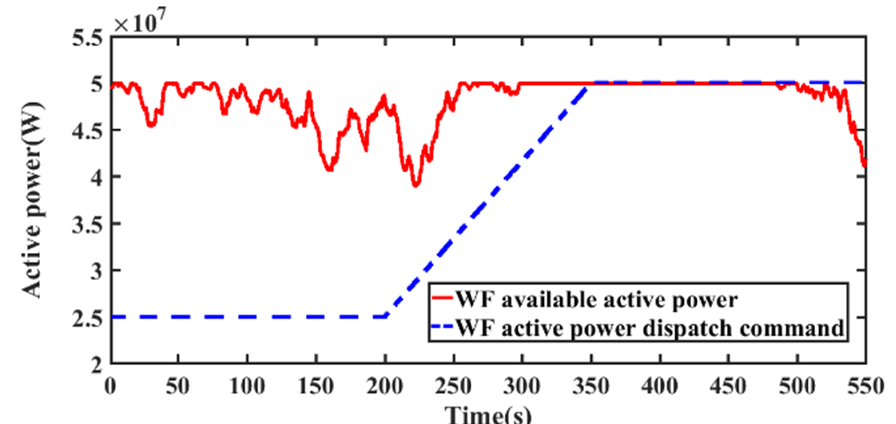
Figure 11. WF total available and reference active power.